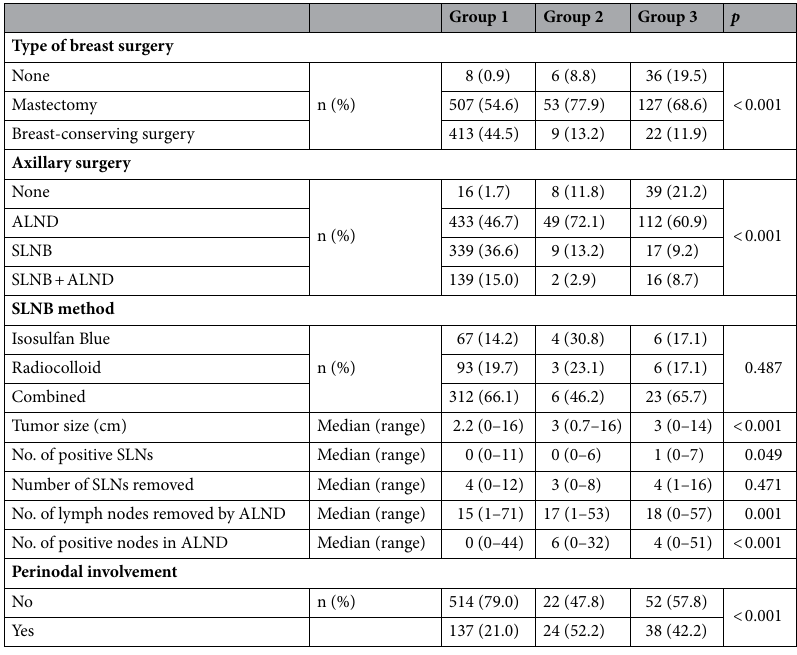
Table 2. Surgical treatment methods. ALND axillary lymph node dissection, SLNB sentinel lymph node dissection.